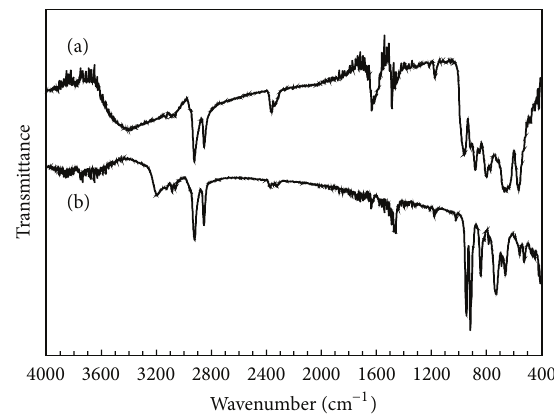
Figure 1: IR spectra of (a) C 16 py-Mo-blue (starting material) and (b) C 16 py-H 2 Mo 8 (obtained